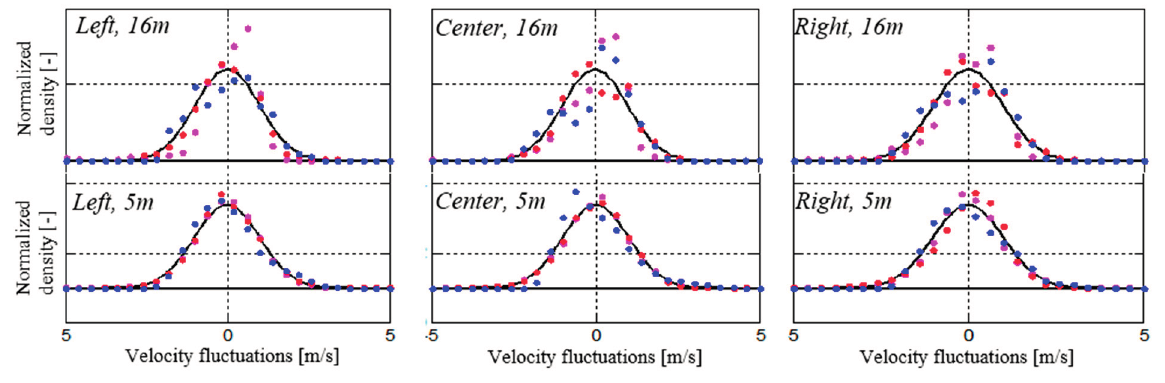
with the Eurocode model. In those figures, the results from LES are compared with the Eurocode profiles (Equations (1) and (2)), with a roughness length of to (cid:1878) (cid:1848) = 31.6 m/s. This based velocity is found to be directly proportional to the top boundary (cid:3029) condition